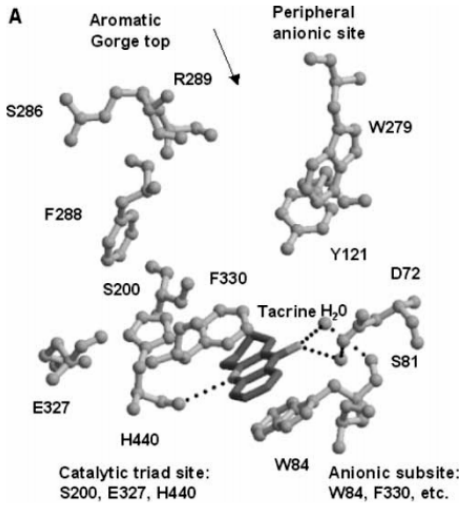
Figure 20. Overlay of the trigonal crystal structure of tacrine (black) and Tc AChE (gray) complex: showing the catalytic anionic site, aromatic gorge, and peripheral anionic site. Reproduced with permission from [100].